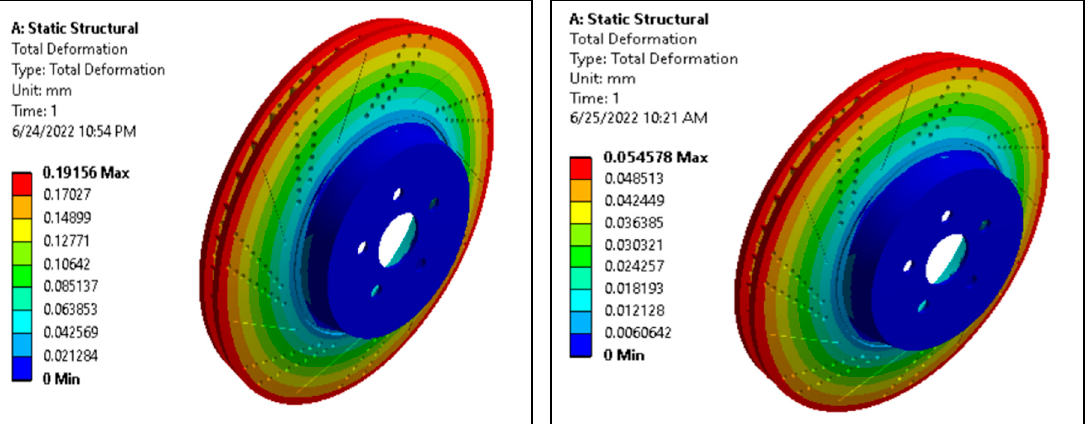
Figure 5. Total deformation of aluminum alloy and AMNCs ventilated disc.